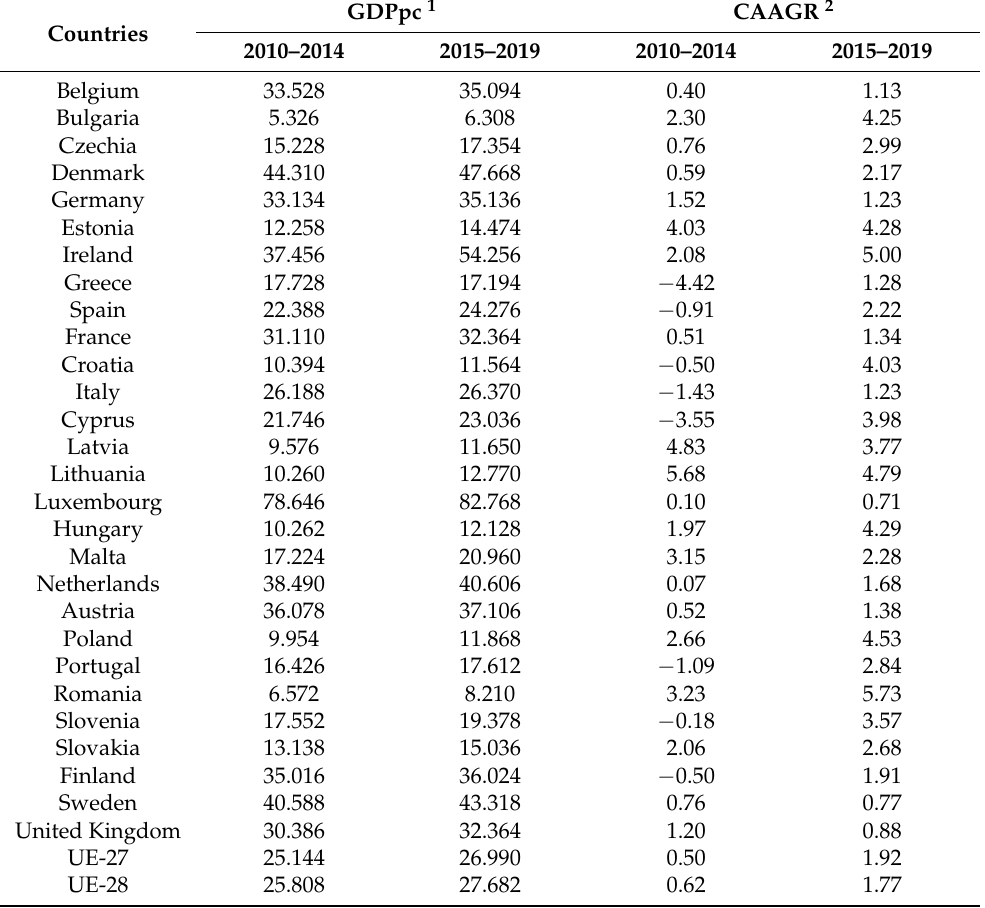
Table 2. Gross Domestic Product per capita (2010 constant prices in purchasing power parity).